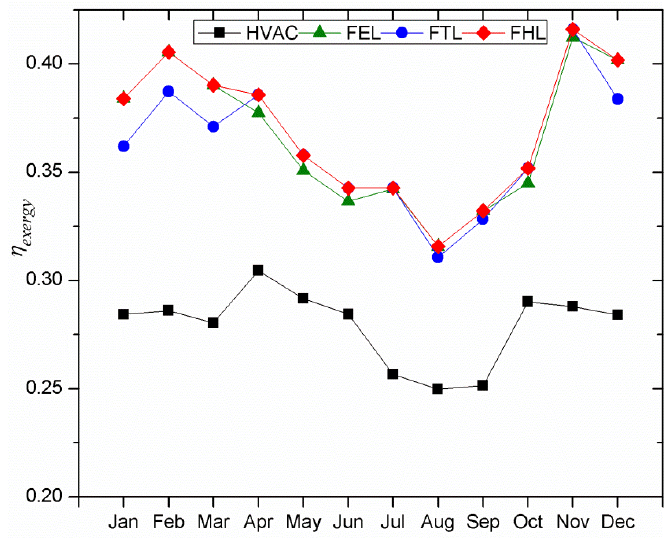
Figure 10. The exergy efficiency of HVAC system and CCHP system in FEL, FTL, and FHL mode based on simulated